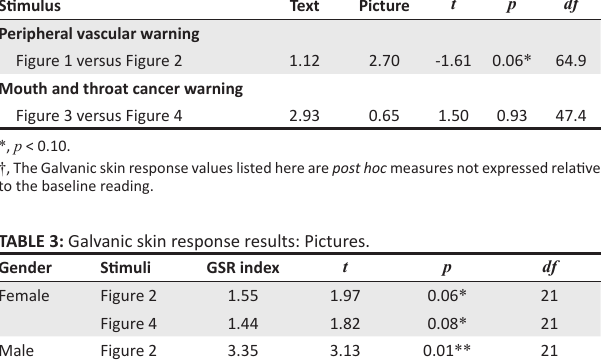
TABLE 2: Galvanic skin response results: Pictures versus text †. Stimulus